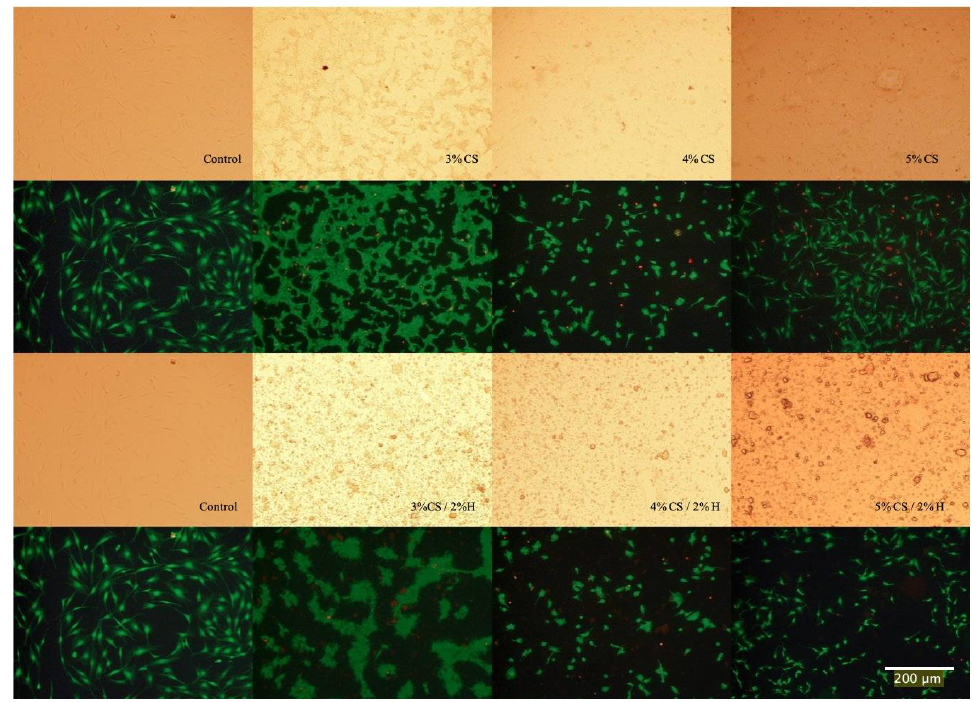
Figure 8. Live/Dead Assay of cells cultured on CS and CS/HNTs. Compared to control, there are live cells (green) observed on the film-coated plates, but the number of dead cells (red) has increased as compared with the control plate but remain few in number. This indicates cells can adhere and proliferate on CS and CS/HNTs substrate. However, cellular morphology was influenced by the surface features and physicochemical properties of substrate.